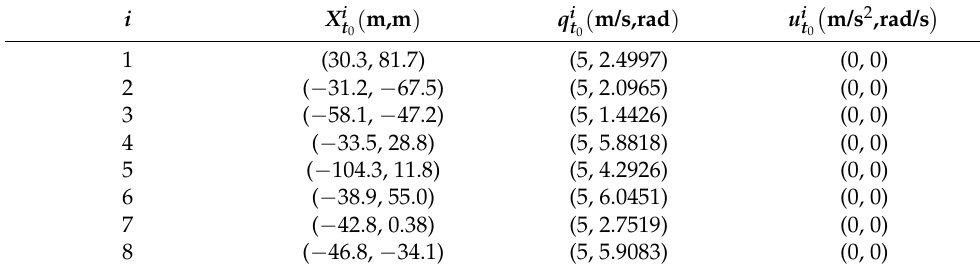
Table 2. Initial states of test 2.